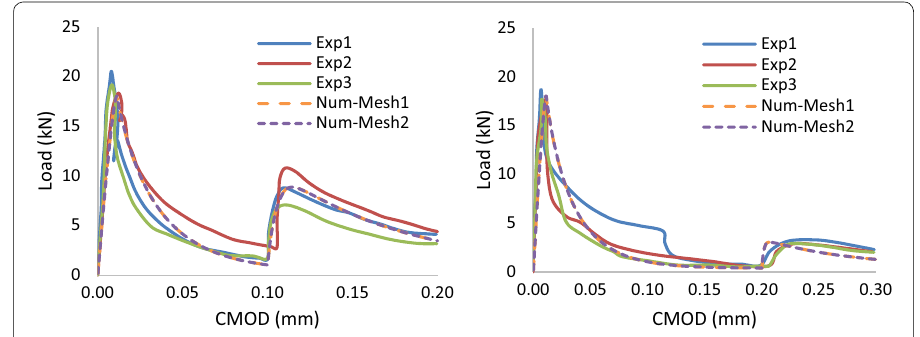
Fig. 9 Comparison of load‑CMOD curve with experimental data for a fixed healing period of 60 s and crack widths of 0.1 mm (left) and 0.2 mm (right)